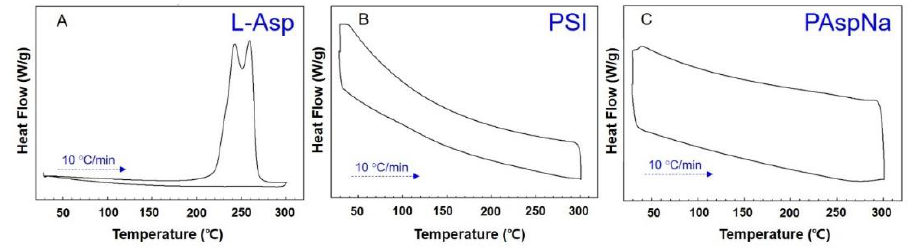
Figure 4. DSC thermograms of ( A ) L-Asp, ( B ) PSI, ( C ) PAspNa.